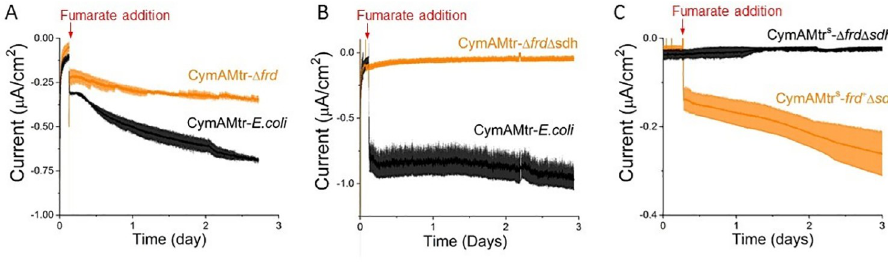
Fig 3. Fumarate-triggered current consumption in CymAMtr- E . coli requires E . coli fumarate reductases. (A) Current consumption by the CymAMtr- E . coli in the wt (black) and Δ frdABCD (orange) background upon addition of fumarate, showing reduced current consumption in the Δ frdABCD background. (B) Current consumption by CymAMtr- E . coli in the wt (black) and Δ frdABCD Δ sdhABCD (orange) backgrounds upon addition of 50 mM fumarate, showing that current is not consumed when fumarate reductase is absent. (C) Current consumption by CymAMtr-E. coli in the Δ frdABCD Δ sdhABCD (black) and frdABCD- complemented Δ sdhABCD background (orange). All the experiments were performed under anaerobic conditions with the cathode poised to -560 mV Ag/AgCl . Addition of fumarate is indicated by the red arrow, and the bars indicate the standard deviation in current from three bioelectrochemical